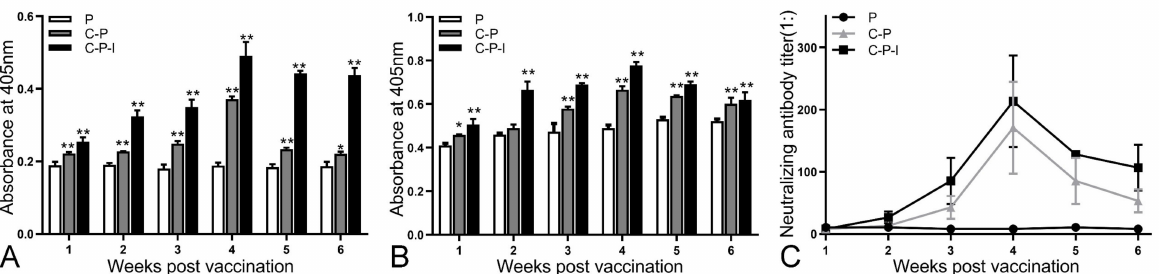
Figure 7. Changes of antibodies in serum from one to six weeks after immunization. Specific antibodies against NNV ( A ), total antibodies ( B ), and neutralizing antibody titers ( C ) from 1st to 6th weeks after immunization in vaccinated grouper were evaluated. P: pBudCE4.1 group; P-I: pBudCE4.1-IRF3 group; C-P: CP-pBudCE4.1 group; C-P-I: CP-pBudCE4.1-IRF3 group. The data are presented as the means ± SD of three fish. Asterisks (*) on the bar represent the statistically significant difference, * p < 0.05, ** p <